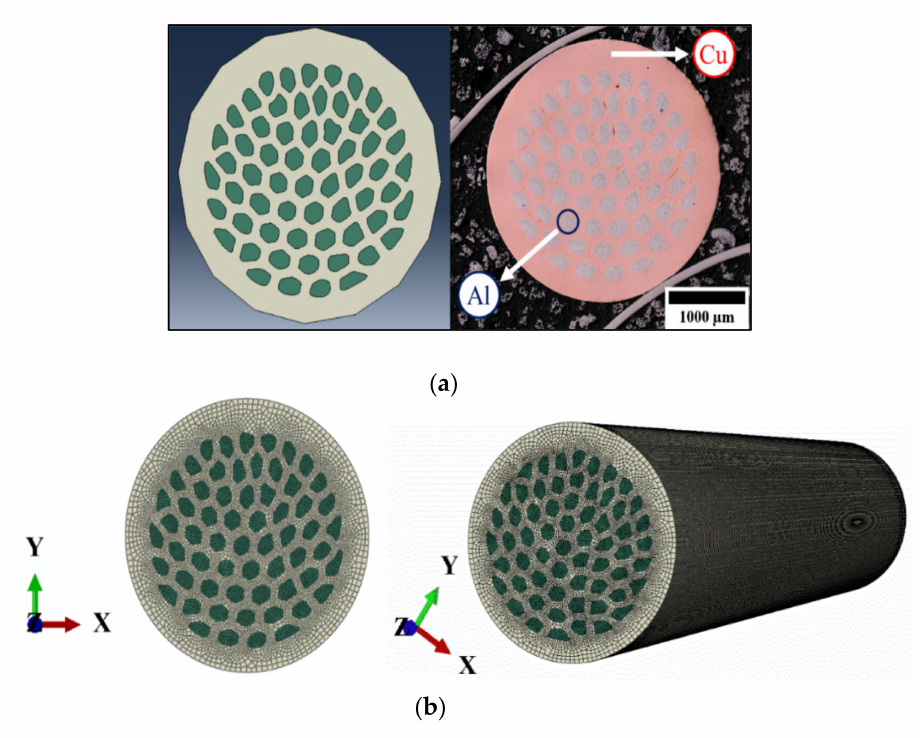
Figure 3. ≈ 25%Al-ACCA sample and corresponding finite element models ( a ) actual microstructure and corresponding FEA model ( b ) meshed ACCA wire